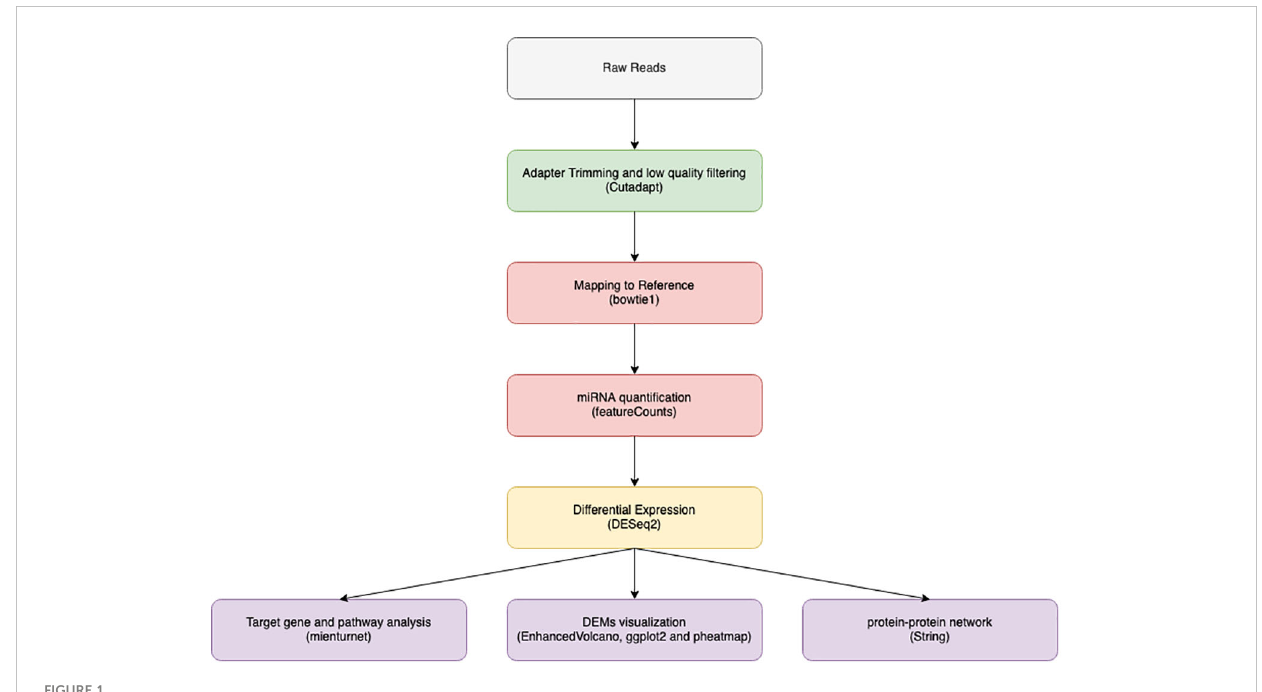
FIGURE 1 Illustrate data analysis work fl ow from data fi ltration through adaptor trimming by cut adapt, alignment using bowtie 1 and fi nally miRNA quanti fi cation using feature count to be used in downstream analysis by